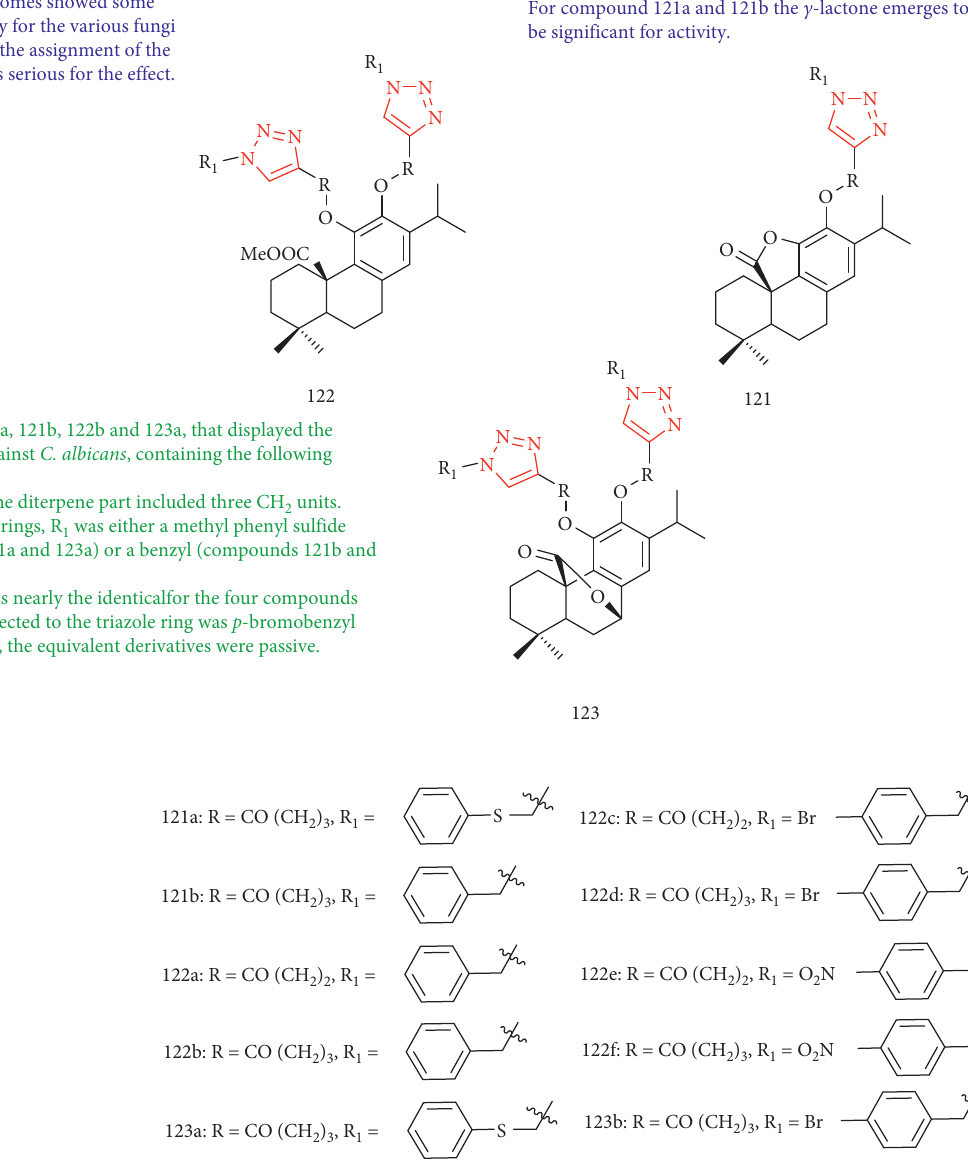
Figure 58: Chemical structure of 1,2,3-triazole-substituted carnosic acid and carnosol